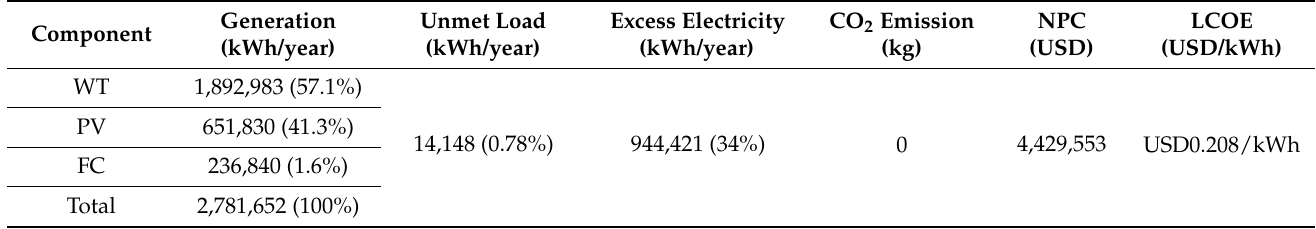
Table 13. Simulation result of S3.